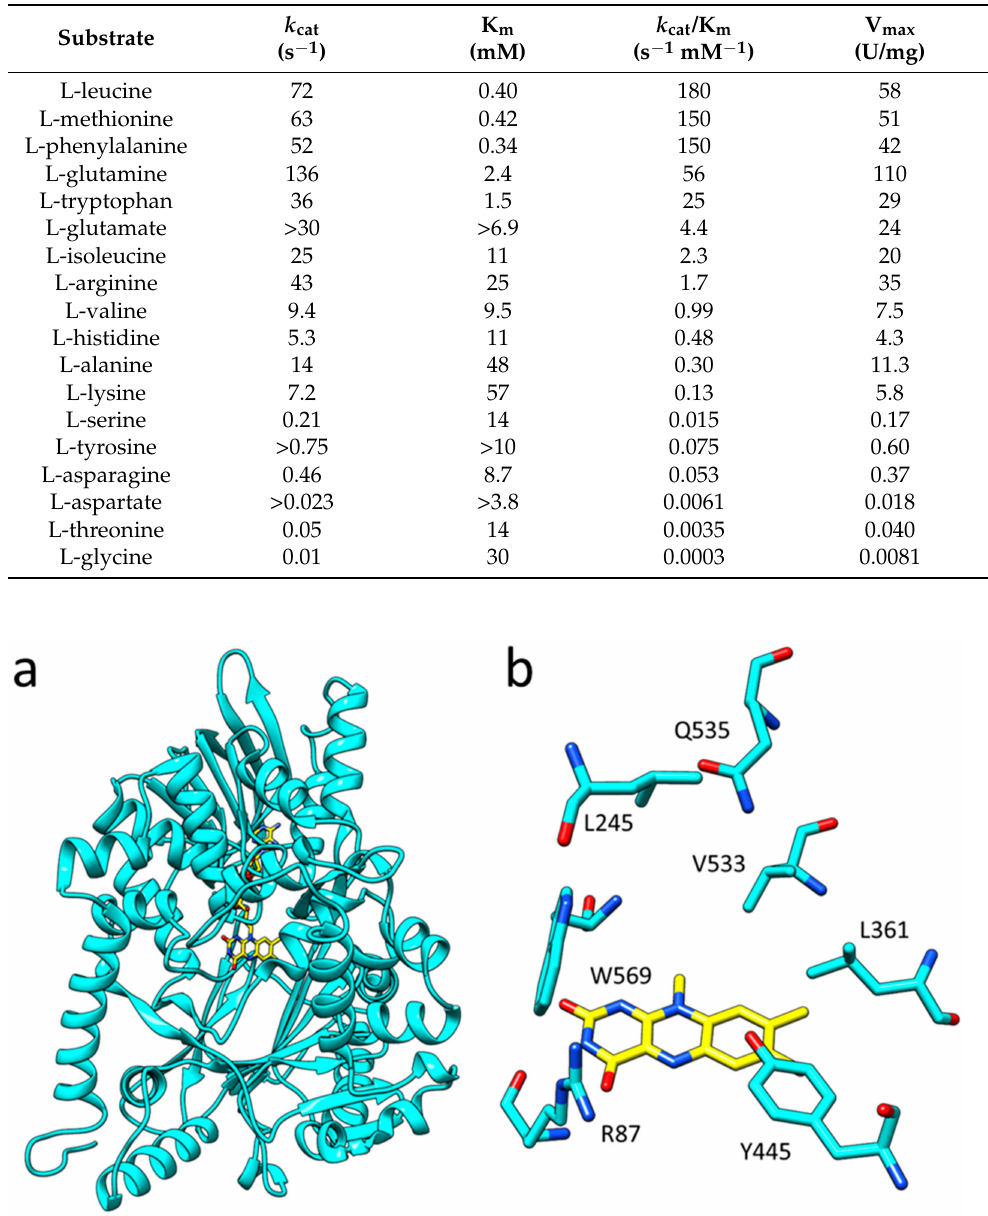
Table 1. Steady state kinetic parameters for amino acid substrates, ordered from highest to lowest k cat /K m values. For L-glutamate, L-aspartate, and L-tyrosine, the individual kinetic parameters, k cat and K m , could be determined because of the relatively high K m values in combination with relatively low solubility of some of these substrates.